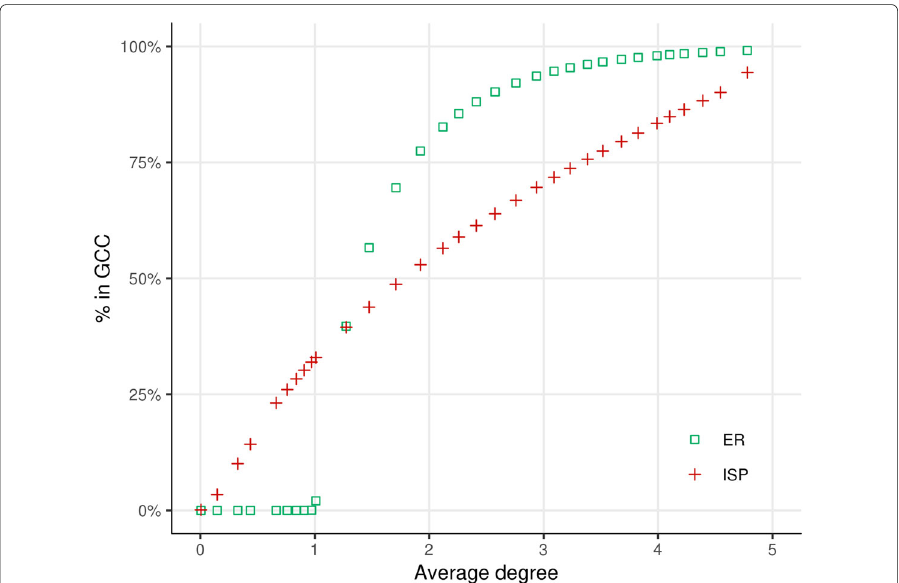
Fig. 7 Giant component compared to average degree: we compared the monthly evolution of the ISP network (red crosses) with a series of a Erd˝os-Renyi random graphs with same number of vertices and edges (green squares). Each point ( x i , y i ) represents a monthly observation of the network ISP (or its relative ER graph) that exhibits a mean degree (cid:6) k (cid:7) = x i and a percentage y i of nodes connected in its largest connected component. The ISP network (red) does not show phase transition, while Erd˝os-Renyi (green) graphs do just after (cid:6) k (cid:7) = 1. It should be noticed that each point of the random reference model is the result of the averages of 10 different ER graphs. However, the different realisations return very stable values; for example, the GCC emerges (i.e., size of the largest component exceeds 50% of total nodes) when mean degree is between 1.383 and